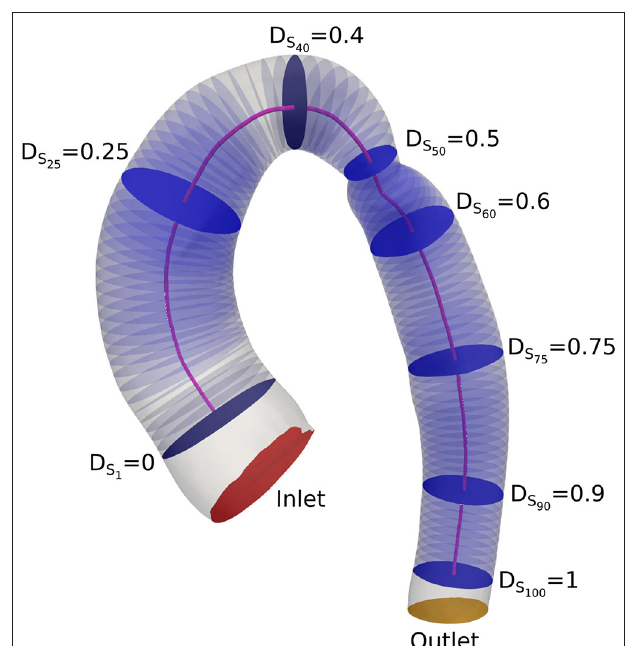
FIGURE 3 | Location of the cross-sections and the